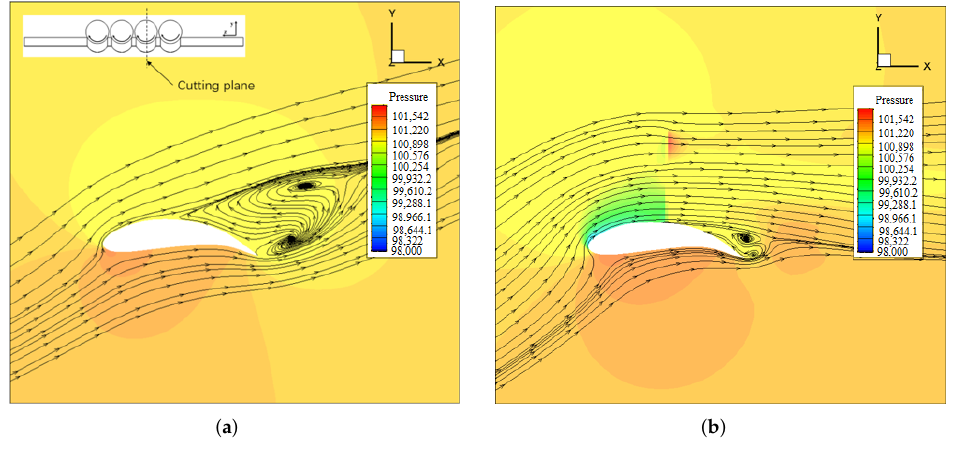
Figure 20. The flow separation for Prop-on and Prop-off condition at α = 24 ◦ . ( a ) Prop-off; ( b ) Prop-on.